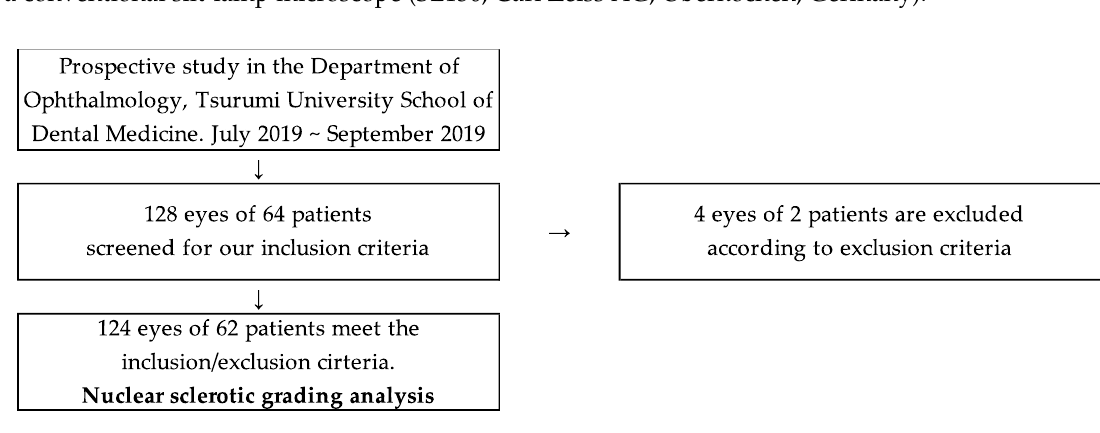
Figure 1. Study flowchart.